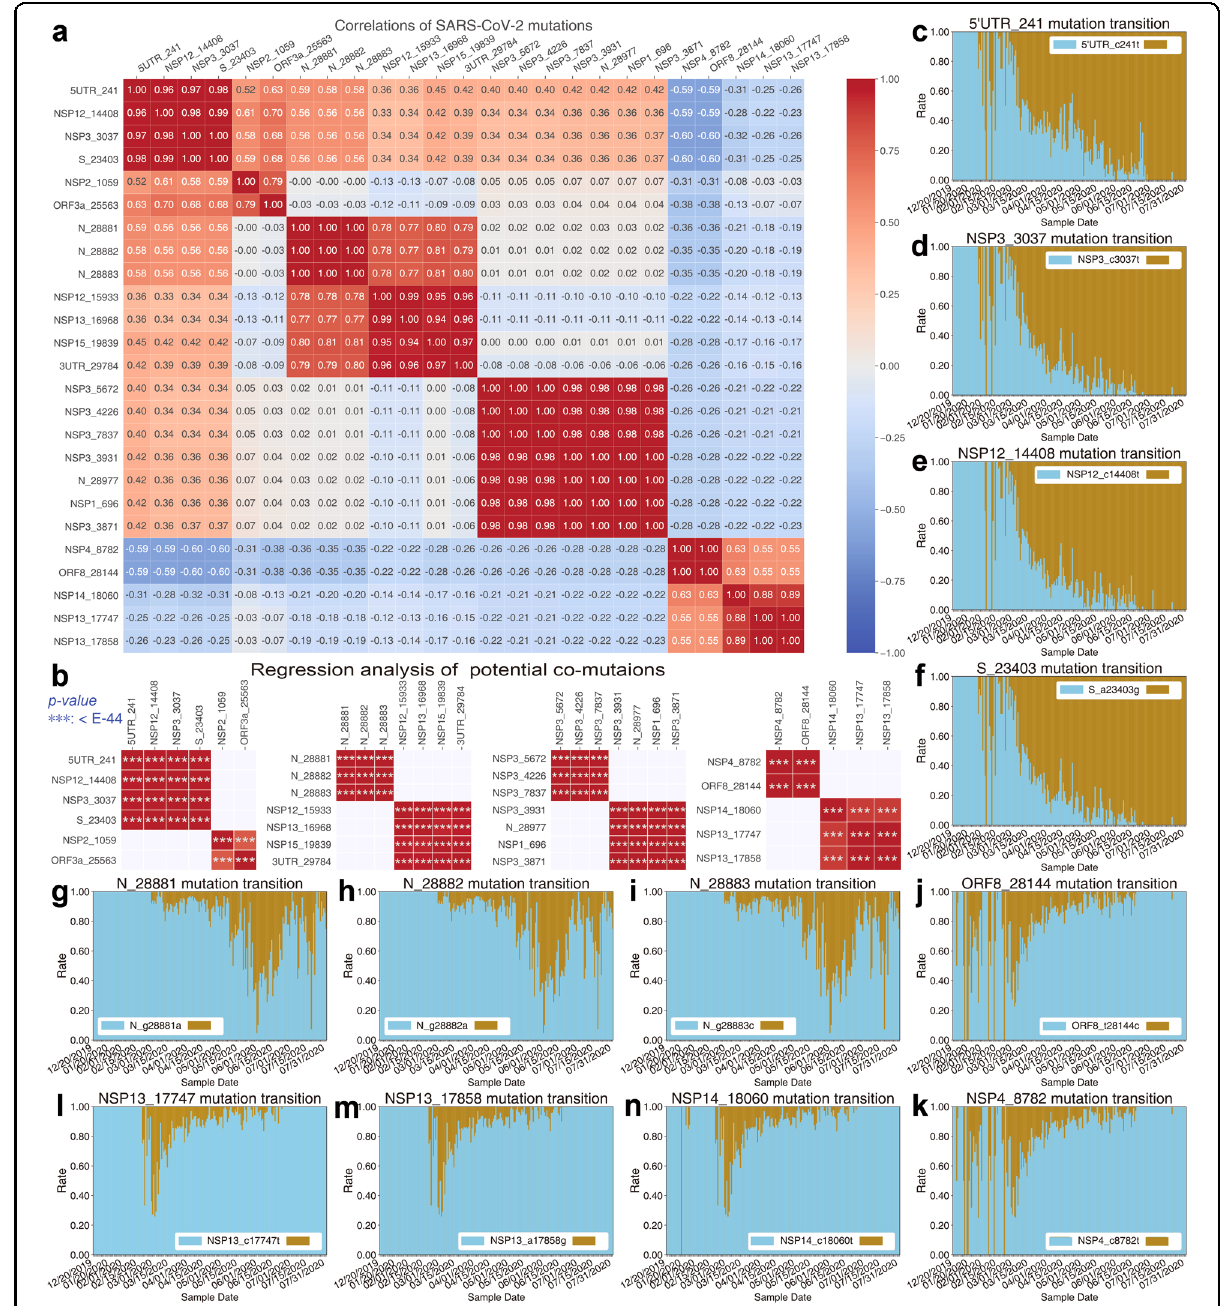
Fig. 3 The strong correlations suggest that the top 25 mutations form eight potential co-mutation patterns. a The correlation heatmap of the top 25 mutations. These mutations could be grouped into several clusters with high Pearson-correlation-coef fi cient (PCC). b Regression analysis of mutations shows that eight clusters all denote the statistical signi fi cance level: *** P -value < E-44. c – f , g – i , j – k , and l – n show the transitions of the high-frequency mutations. The sky-blue represents the rate per day of initial residue in population and the golden represents the rate per day of substitution/mutant. These mutation transitions provide further evidence that the above mutations potentially form co-mutation